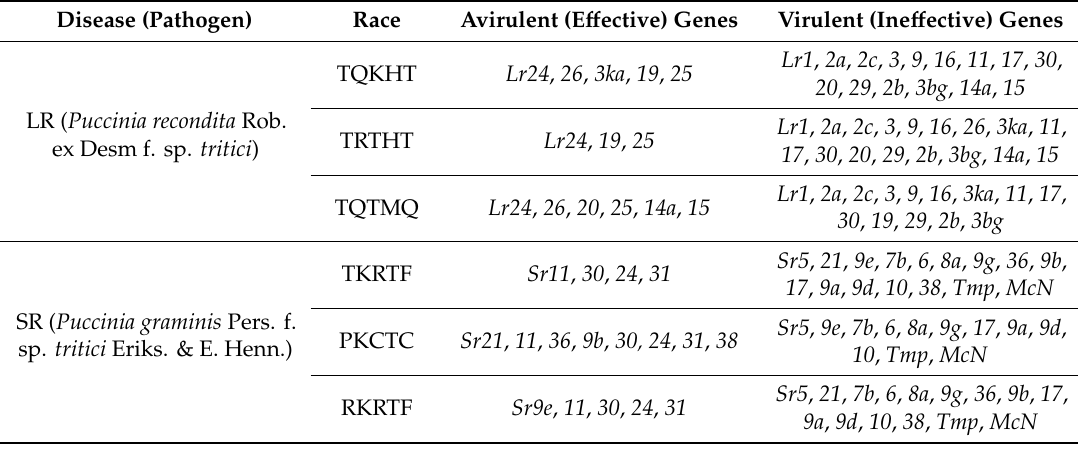
Table 1. Virulence / avirulence pattern of pathogen races used in the study. Disease (Pathogen) Race Avirulent (E ff ective) Genes Virulent (Ine ff ective) Genes